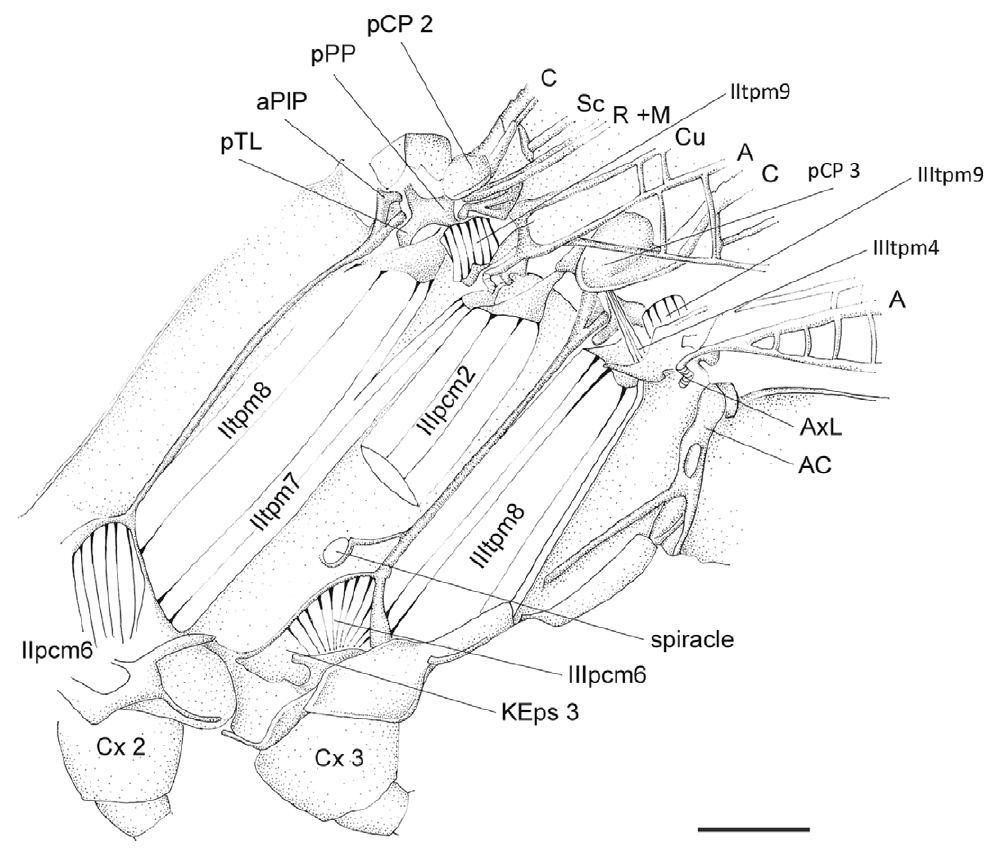
Figure 12. C.splendens , lateral thorax musculature, longitudinal cut, right. Abbreviations: A – anal vein, AC – antecosta, aPlP - anterior pleural process, AxL – axillary ligament, C – costa, Cu – cubitus, Cx – coxa, KEps – katepisternum, M – media, pCP – proximale costal plate, pPP – posterior pleural process, pTL - posterior tergal levler, R – radius, Sc – subcosta.